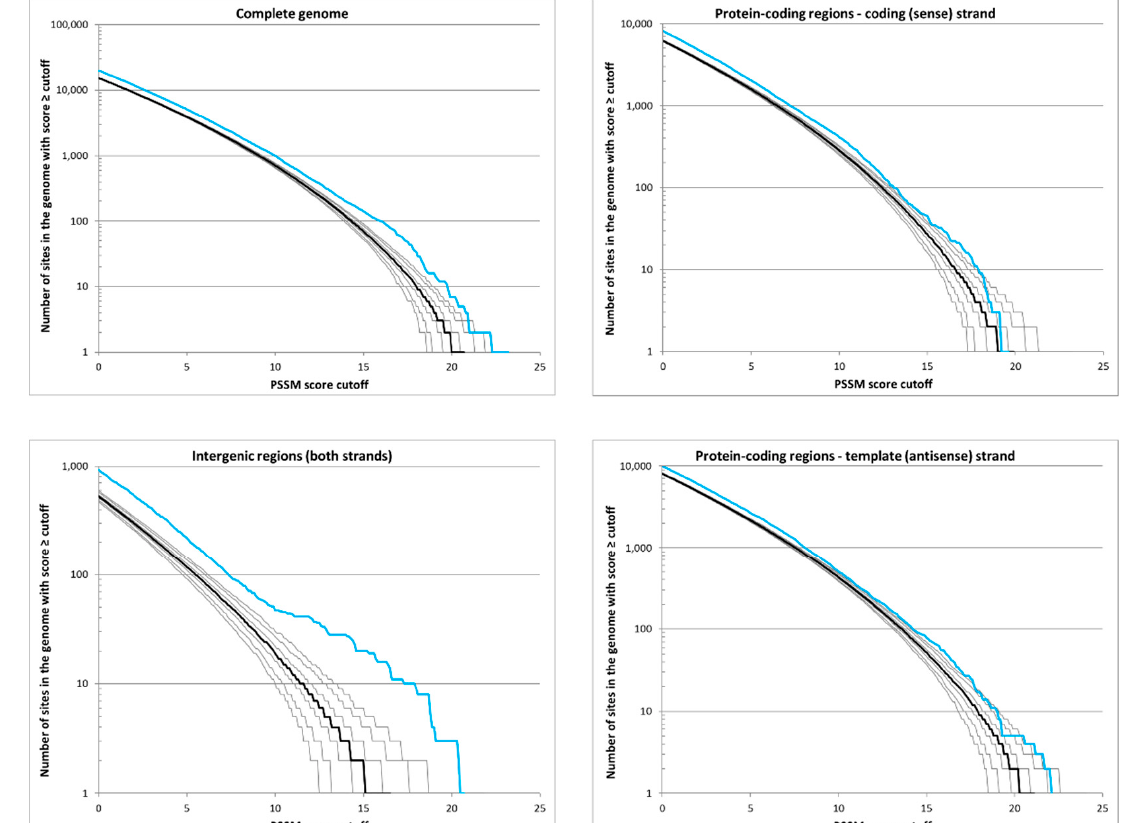
Figure 4. Reverse cumulative distributions of PSSM scores for motifs that resemble GCGC-containing promoters in the H. pylori 26695 genome. The blue line represents the observed values for the H. pylori 26695 genome, and the black lines represent the random sequences. The y-axis indicates the number of sites in the genome with scores greater than or equal to the PSSM score cutoff indicated on the x-axis. The thick black line represents the median for 1000 random sequences, and the thin black lines correspond to the 90th, 95th, and 99th percentiles.